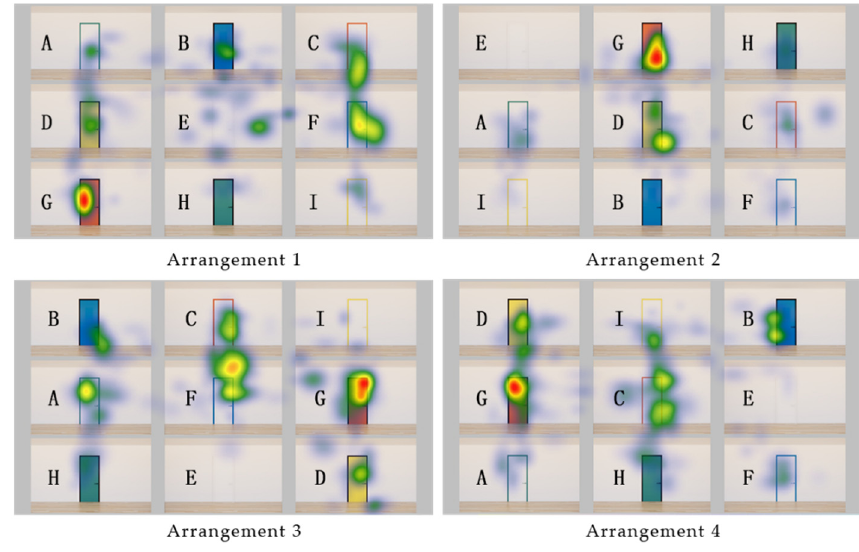
Figure 4. Dwell time in different door–frame combinations. The image below (Figure 5) is the heat map generated from the eye-tracking data. A heat map is composed of “gaze patterns over the stimulus image visualized as a colored map”[27] (p. 104). The image shows the distribution and intensity of data occurring at the observation point. Blue indicates fewer data, and red indicates more data [40]. The heat map shows that, regardless of the arrangement of doors in each image, participants in the experiment focused more on the AOI-G (red-black) color matching than on the other doors.